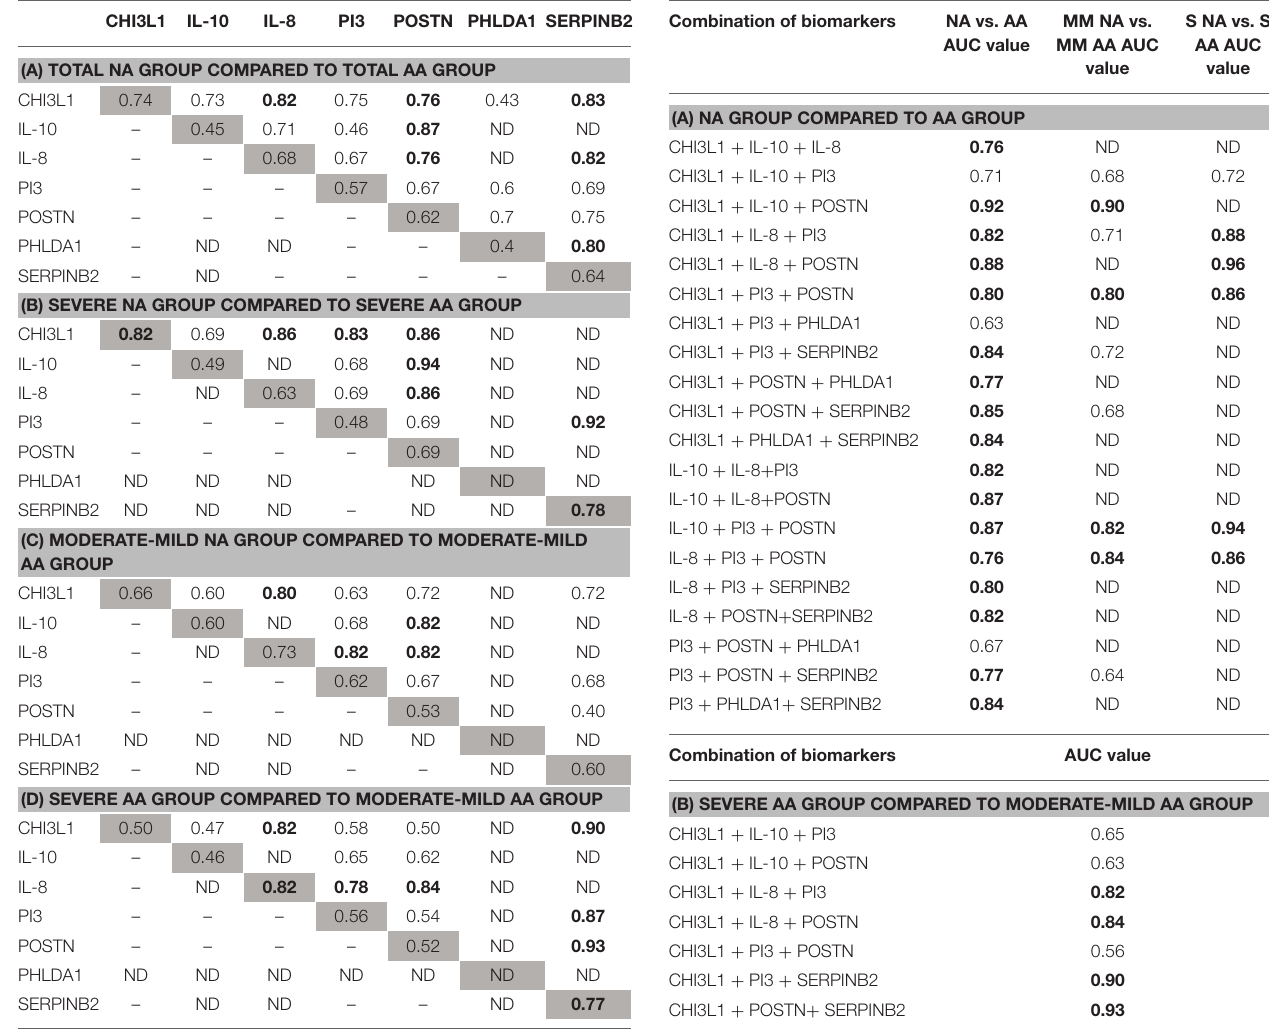
TABLE 3 | Receiver operating characteristic (ROC) curve analyses of the protein expression combining two biomarkers. CHI3L1 IL-10 IL-8 PI3 POSTN PHLDA1 SERPINB2